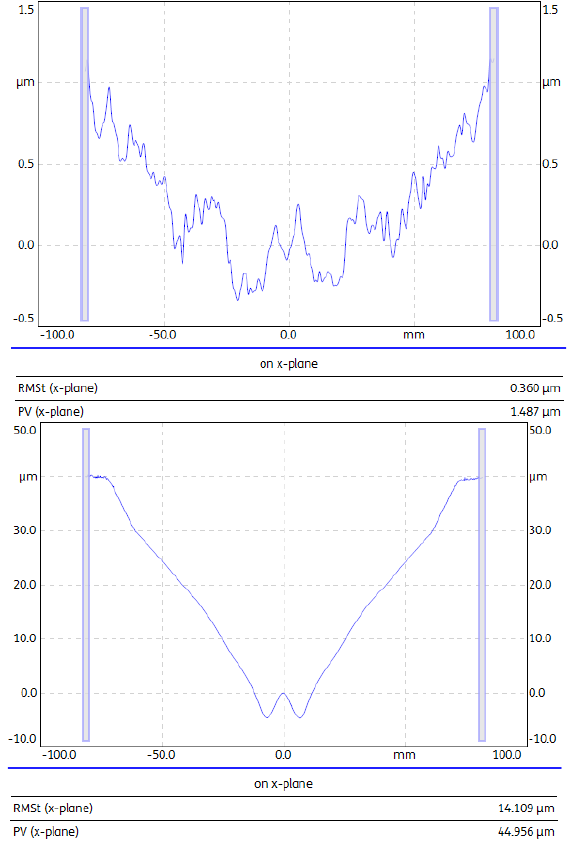
Fig . 7 . Surface form deviation after grinding with the D30 tool on the top. On the bottom the same sample after the V-shape polishing.